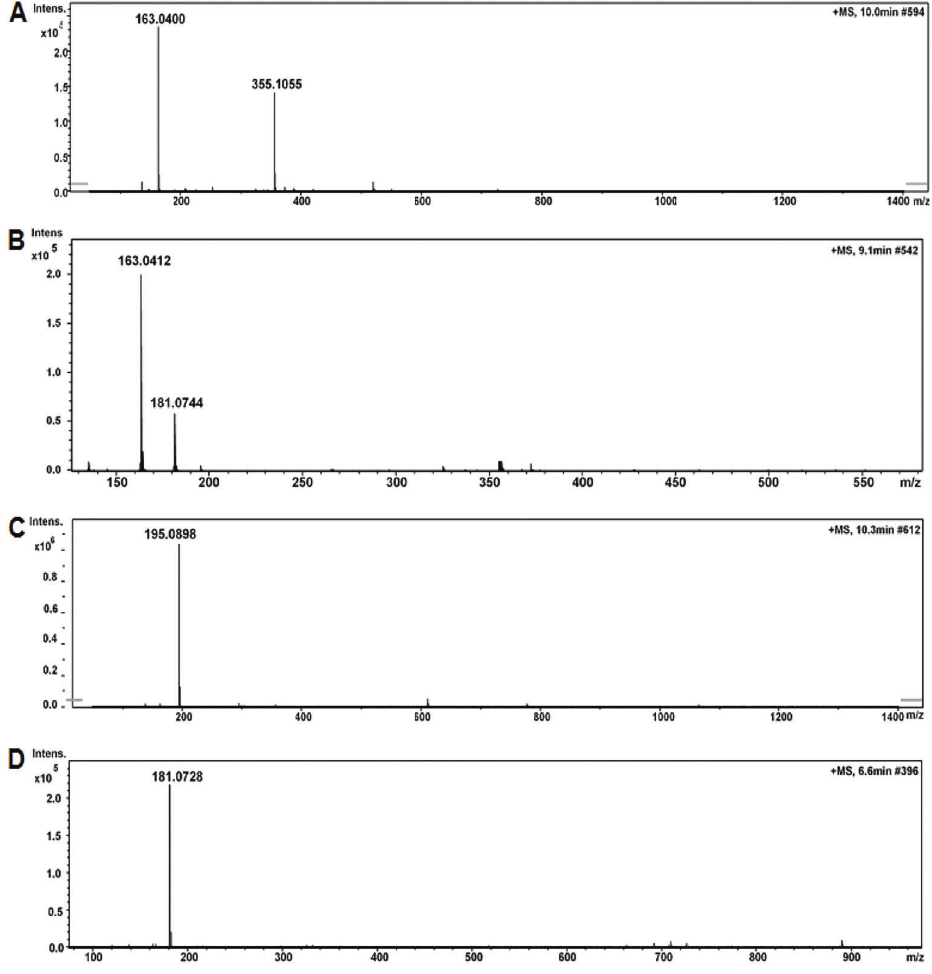
Figure 3. Spectra of ion fragments obtained from analysis of yerba mate ( Ilex paraguariensis ) extracts. Analysis performed by using electrospray ionization in positive ion mode. Ion fragments correspond to chemical compounds presented in Table 1. A , Chlorogenic acid ([M + H] + =355); B , Caffeic acid ([M + H] + =182); C , Caffeine ([M + H] + =195); D , Theobromine ([M + H] +